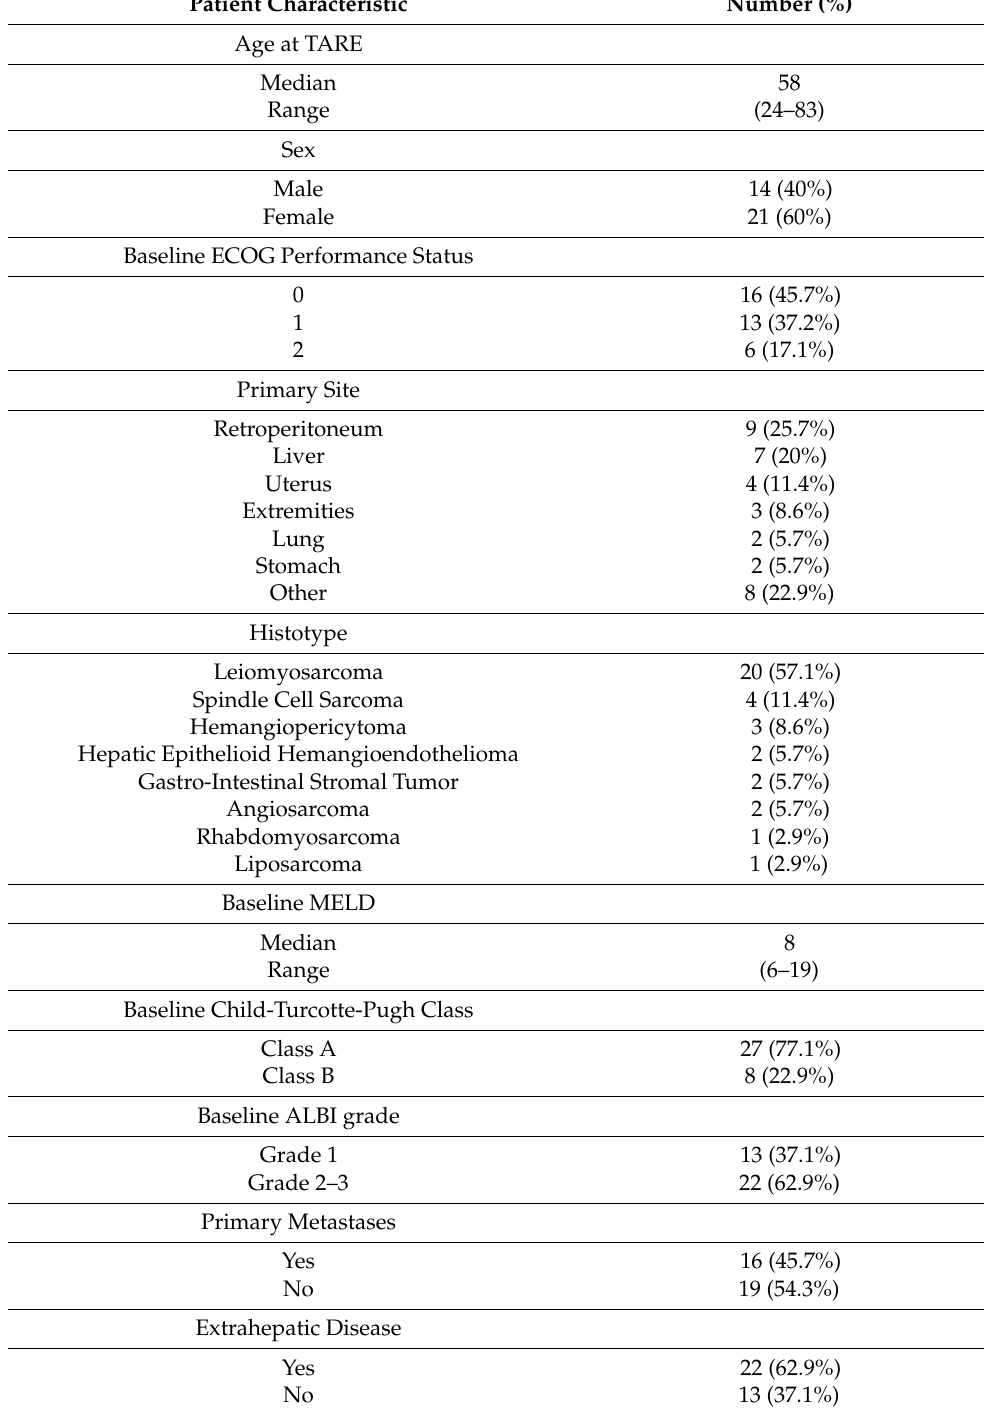
Table 1. Patient characteristics and